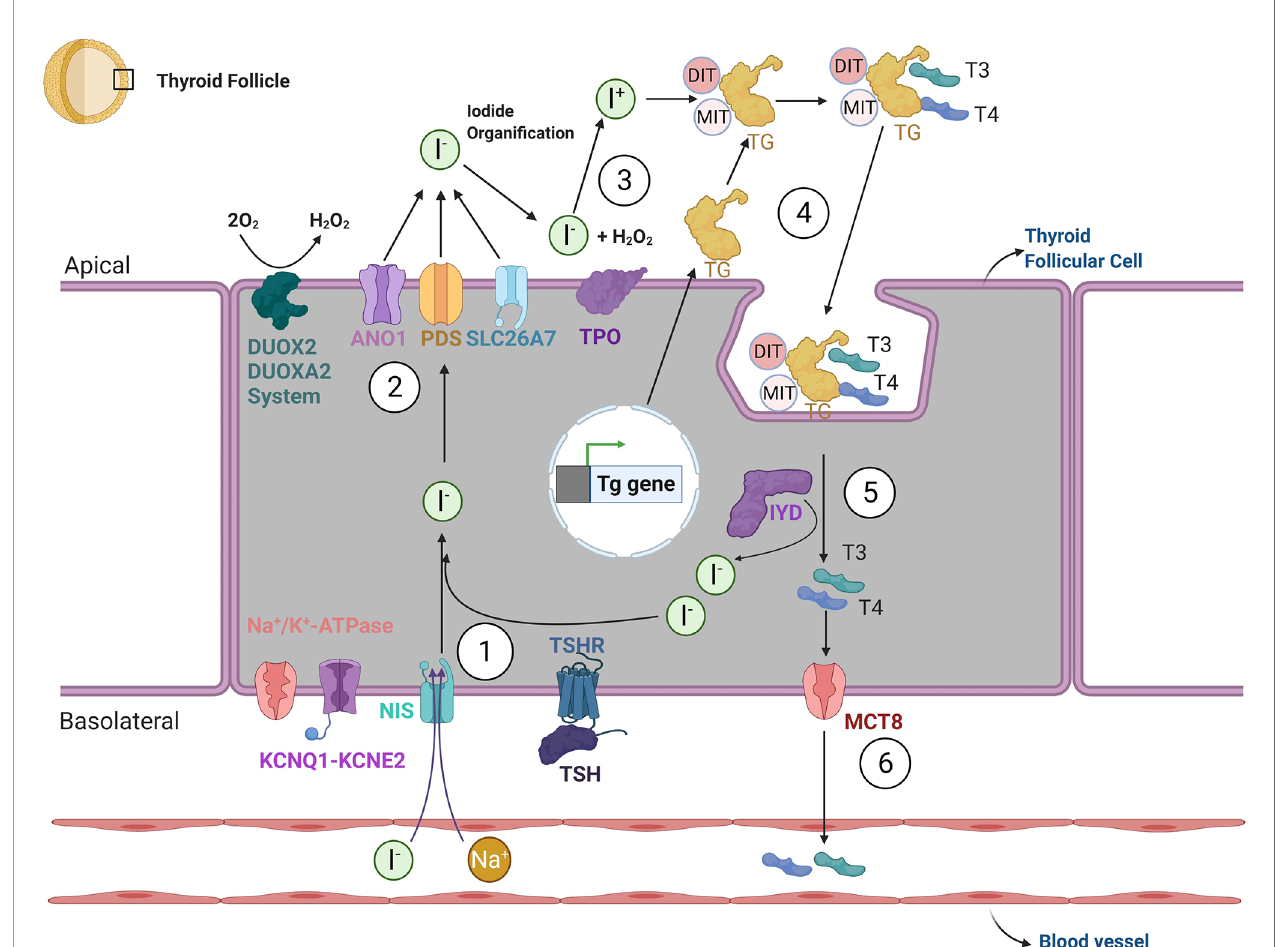
FIGURE 2 | Thyroid hormone biosynthesis. The biosynthesis of thyroid hormones can be summarized through six steps. 1. Iodide reaches the cytosol of thyroid follicular cells via an active transport mechanism, mediated by sodium-channel iodine - Na+/I − - symporter (NIS; also known as SLC5A5). NIS activity is generated by the sodium gradient created by the Na/K-ATPase and KCNQ1-KCNE2 potassium channel. After crossing the basolateral membrane, iodide reaches the apical membrane after which it will undergo organi fi cation. The movement of iodine across the apical border is mediated by a passive transport system, through potentially the speci fi c channels Pendrin (also known as PDS or SLC26A4) and ANO1 (Anoctamin-1). SLC26A7 may be an additional such transporter. 3. After crossing the apical membrane, the enzyme thyroid-peroxidase (TPO) oxidizes iodide to atomic iodine (I) using a source of hydrogen peroxide (H 2 O 2 ) provided by dual function oxidases (DUOX2 and DUOXA2). 4. In the presence of iodide and H 2 O 2 , TPO catalyzes the iodination of thyroglobulin (TG) tyrosine residues, at the apical plasma membrane; both singly iodinated tyrosine residues (mono-iodotyrosine — MIT) and doubly iodinated tyrosine residues (di-iodotyrosine — DIT) are formed during iodination of thyroglobulin. 5. After the re-internalization of TG from the follicular lumen into the follicle, TG undergoes lysosomal degradation via proteolysis, which liberates thyroid hormones 3,5,3 ′ -triiodothyronine (T3) and 3,5,3 ′ ,5 ′ -tretraiodothyronine (T4). Surplus MITs and DITs are deiodinated by the iodotyrosine deiodinase 1 (DEHAL1/IYD) and iodine is transported to the intrathyroidal iodide pool 6. Finally, T4 and T3 exit the thyroid gland via the monocarboxylate transporter 8 (MCT8) and potentially other modalities. The transcription of speci fi c thyroid genes and thyroid function in vivo is under the control of thyrotropin (TSH) via its protein G-coupled receptor